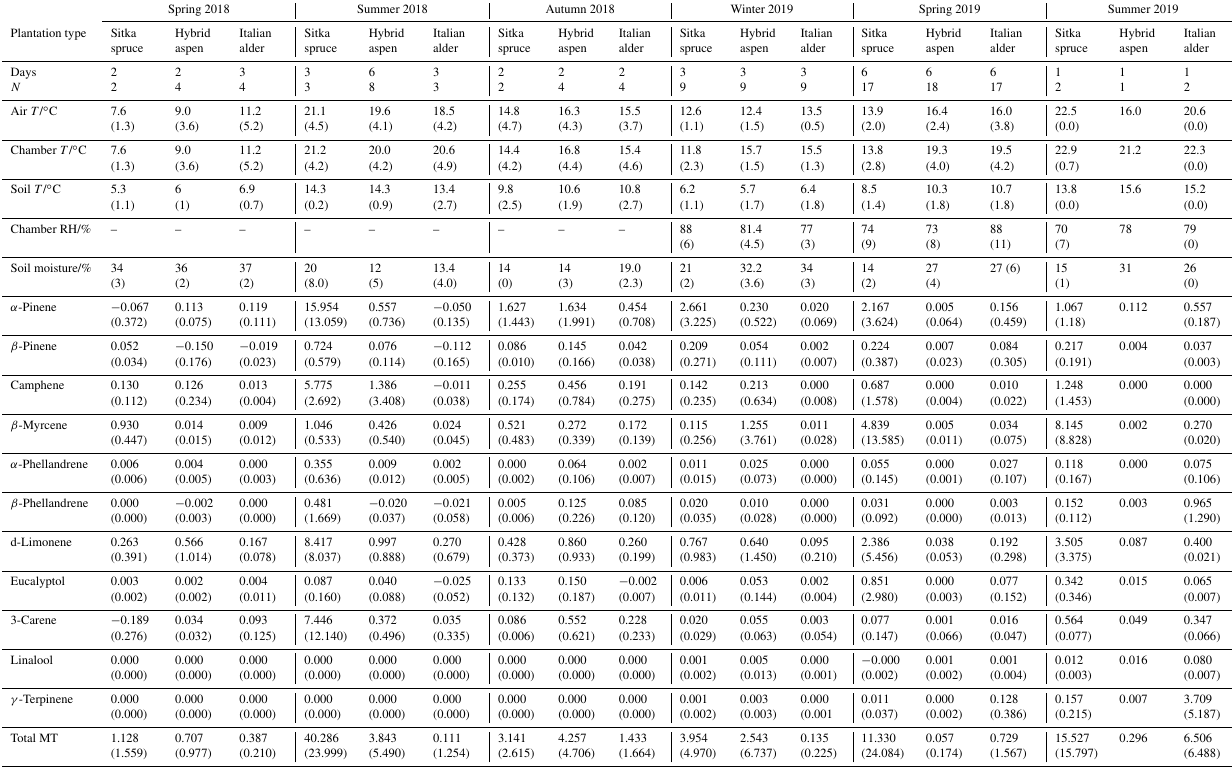
Table 5. Seasonal variation in forest floor emissions (µgCm − 2 h − 1 ) of monoterpenes from Sitka spruce, hybrid aspen and Italian alder SRF plots, at East Grange, Fife, Scotland, in